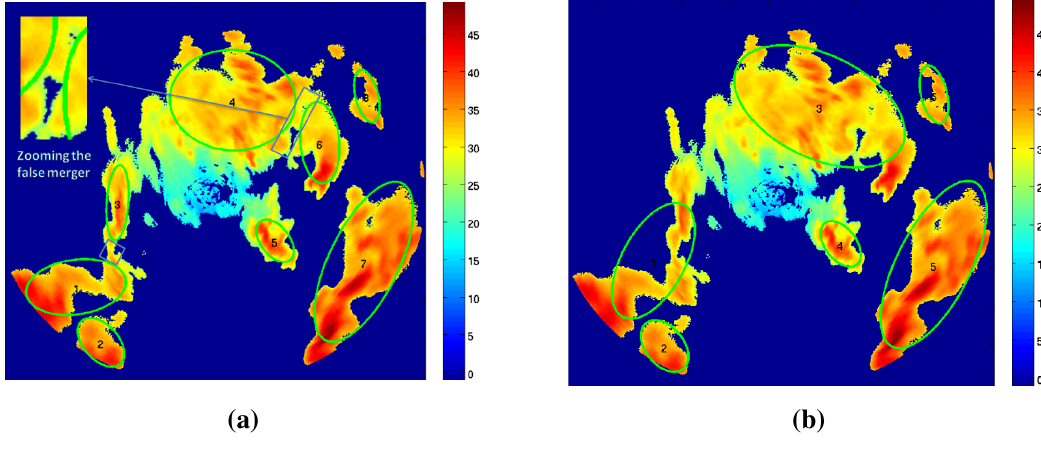
Figure 6. Removal of false merger with morphological erosion. ( a ) Identification with erosion; ( b ) identification without erosion.